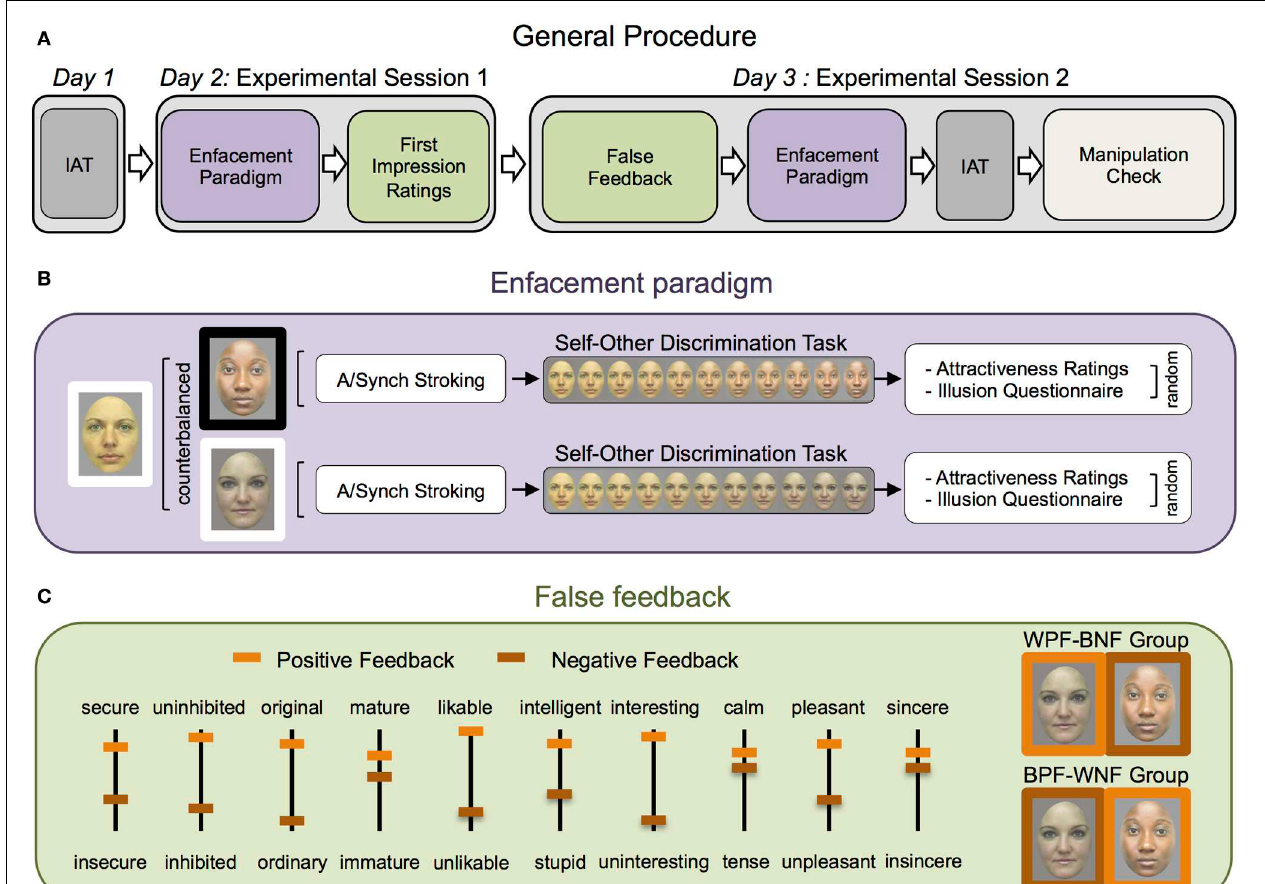
each of the 50 images extracted from the morphing continuum between the self and other face was like their own face, with 0 = “not me at all”; 100 = “completely me”); and in random order: (ii) the attractiveness rating; and (iii) the Illusion questionnaire. (C) To vary the interpersonal perception in the second session, false-feedback about the first impression of both the black and the white partner was given to the participants. Depicted are the globally positive (orange) and negative feedback (brown) on the ten bipolar adjectives-VAS ratings. One group of participants received positive feedback from the white (WPF) and negative feedback from the black (BNF) partner, the other group the